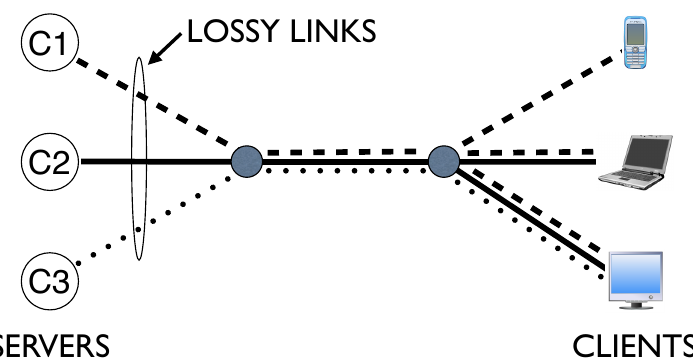
Figure 12. Simulated network